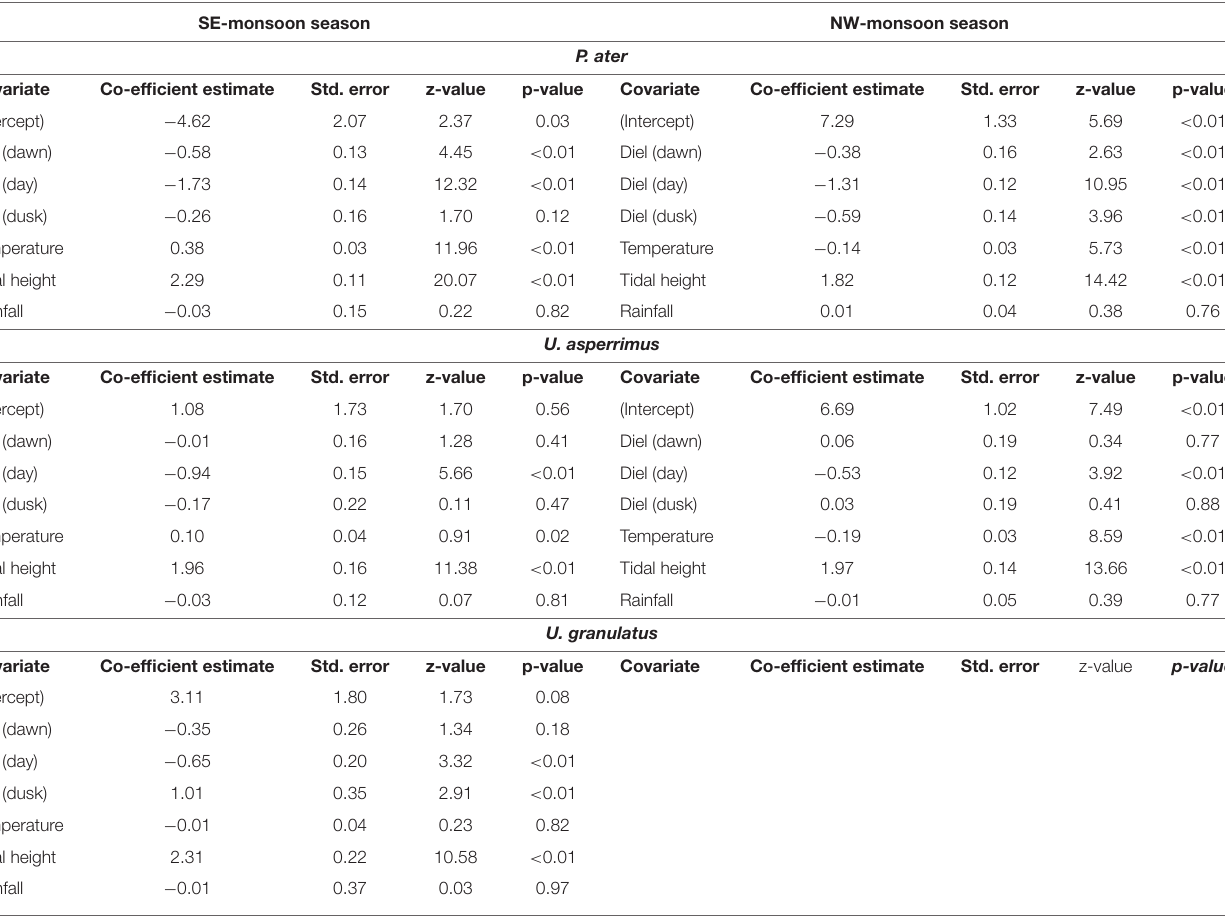
TABLE 5 | Outputs of the Generalized Linear Mixed Models testing whether diel stage, water temperature on the flats, tidal height, or precipitation influenced the probability of P. ater , U. asperrimus , and U. granulatus being detected in the reef flats or lagoon habitats of St. Joseph